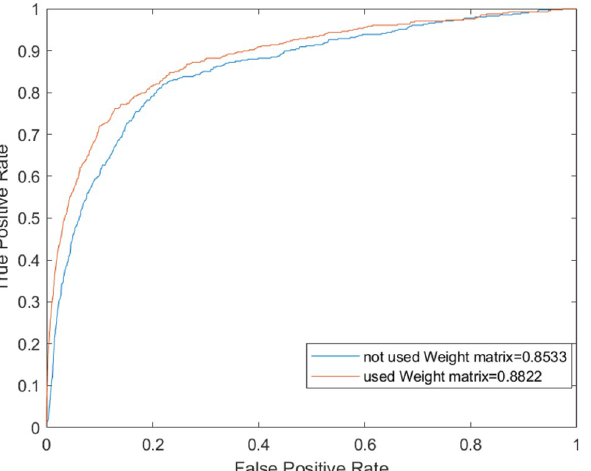
Fig 6. Comparison of ROC curve calculated with weight matrix and ROC curve calculated without weight matrix. https://doi.org/10.1371/journal.pone.0278817.g006 sponging miR-1271 and upregulating MTDH [52]. lncRNA FGD5-AS1 promoted colorectal